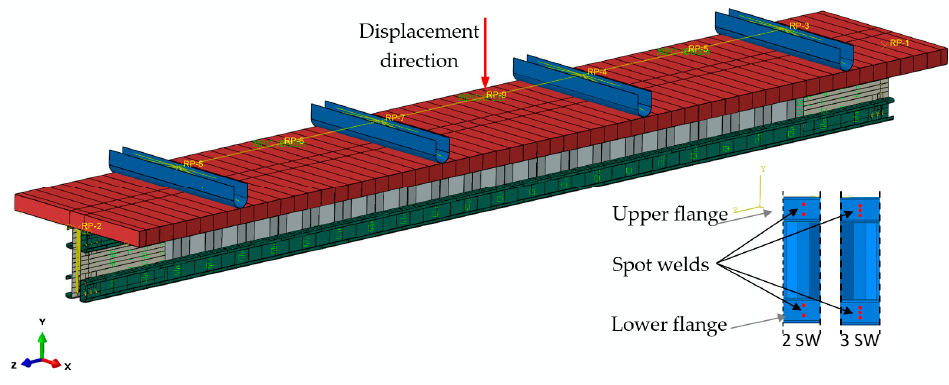
Figure 11. FE model in ABAQUS/CAE with the definition of 2 SW and 3 SW configurations.